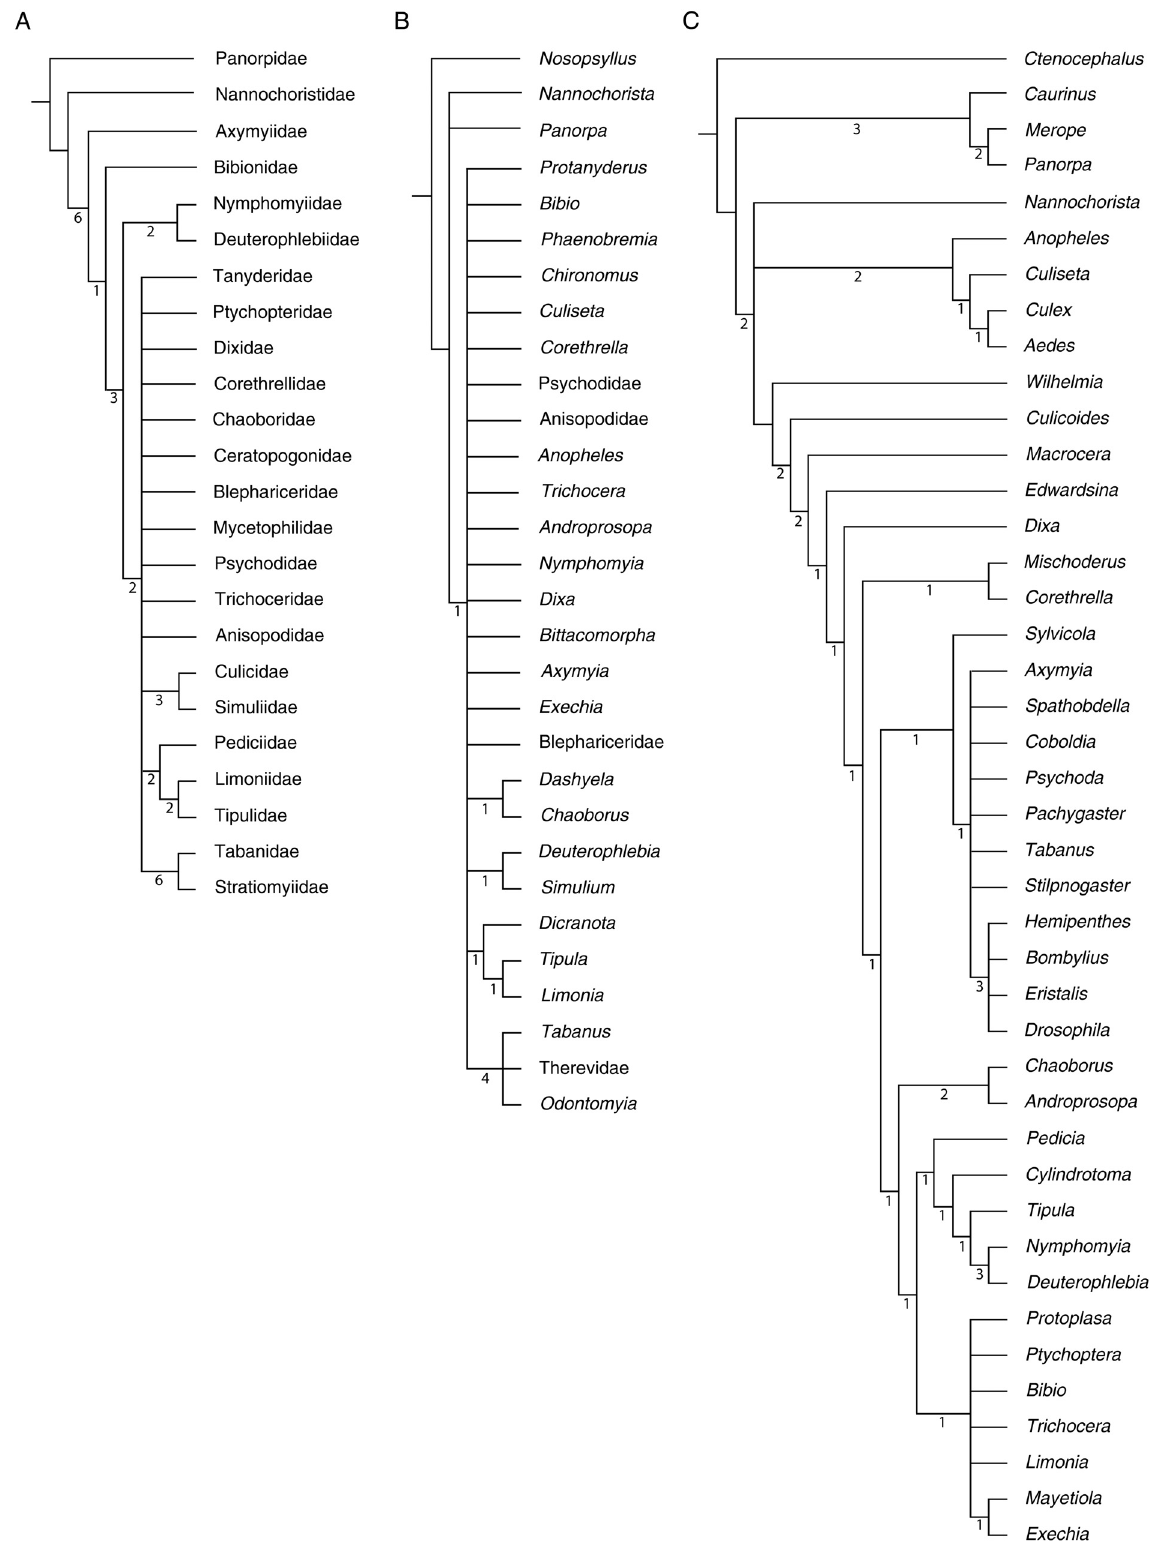
Figure 1 . Strict consensus trees based on: A, the complete data set (length 462, CI 0.33, RI 0.29) (Appendix 6). B, larval head structures (length 239, CI 0.26, RI 0.21) (Appendix 3). C, adult head structures (length 337, CI 0.25, RI 0.48) (Appendix 2). The numbers below the branches shows the Bremer support for the node. The data matrices are given in Nova fi le format in Appendix